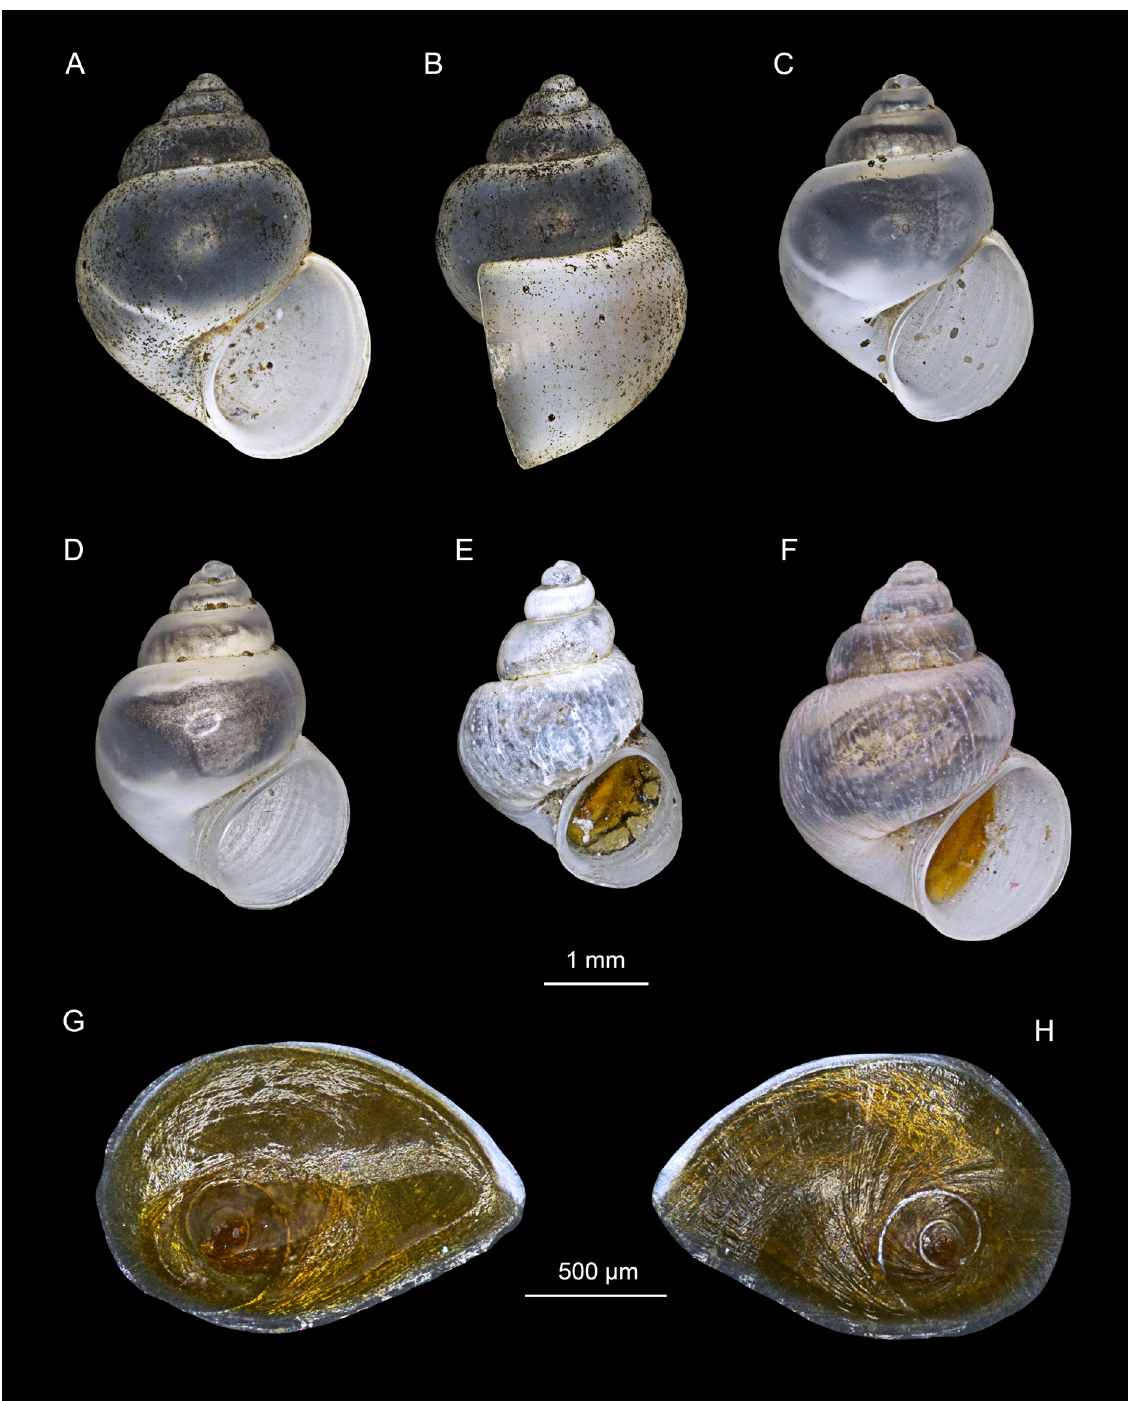
Fig. 26. Shells and operculum of Mercuria lupiaensis Miller & Delicado sp. nov. A–B . Holotype (MNCN 15.05/200123H), frontal and lateral views. C – D . Paratypes (MNCN 15.05/200123P). C–D, G–H . Specimens from Giammateo Creek, Frigole, Lecce. E . Specimen from the spring in Torre Castiglione, Ionian Coast, Porto Cesareo, Apulia (UGSB 16237). F . Specimen from Palude del Capitano Pond, San Isidoro, Ionian coast, Nardò, Apulia (UGSB 16236). G . Operculum, inner side. H . Operculum, outer